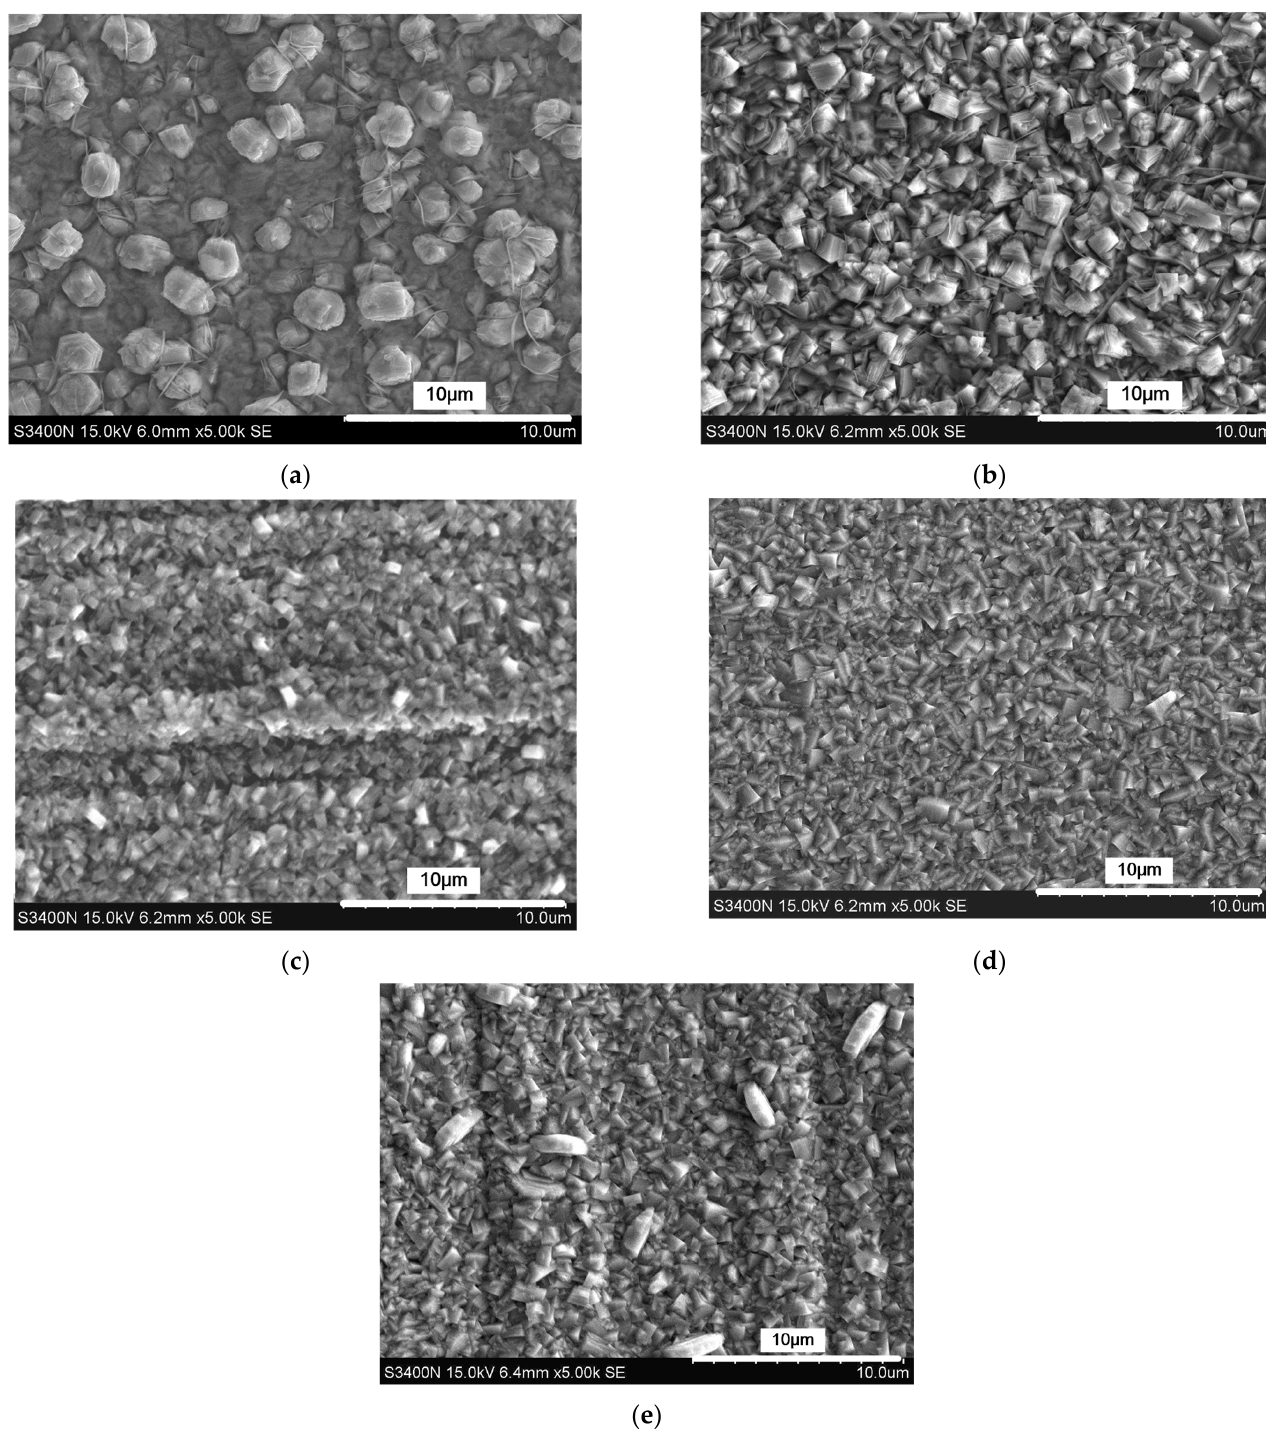
Figure 7. The surface morphology of the deposited coating with different concentrations of CPAM. ( a ) Concentration of CPAM = 5 g/L; ( b ) concentration of CPAM = 10 g/L; ( c ) concentration of CPAM = 15 g/L; ( d ) concentration of CPAM = 20 g/L; ( e ) concentration of CPAM = 25 g/L.